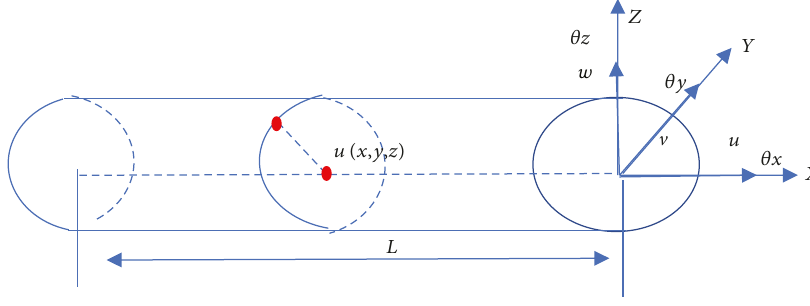
Figure 1: Beam geometry and kinematic